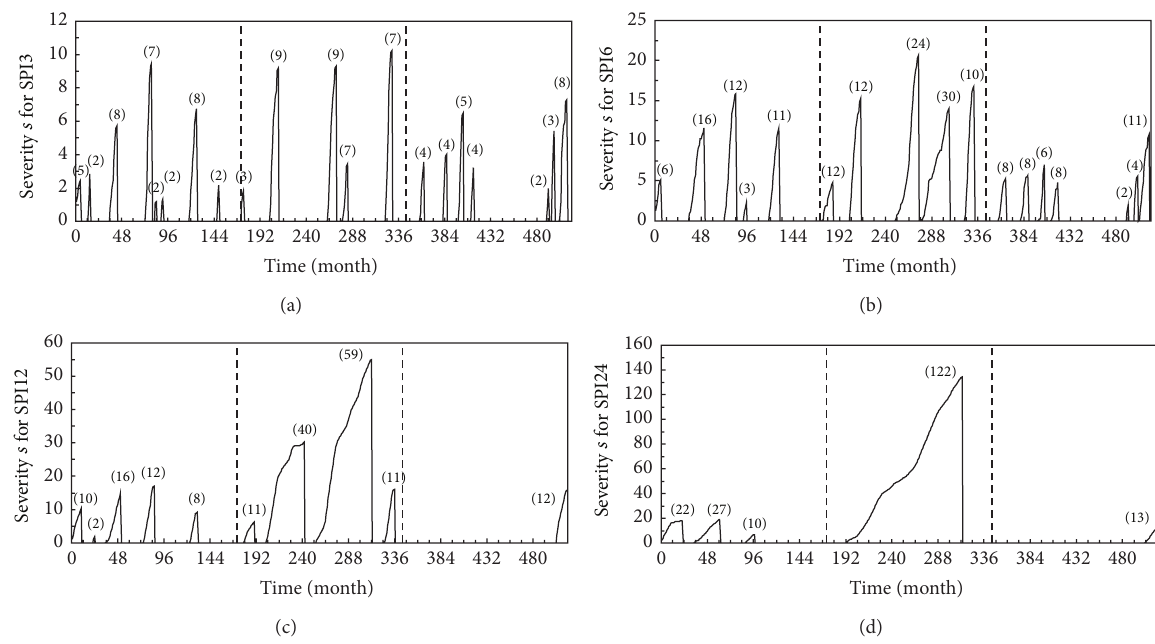
Figure 5: Drought severity for SPI3, SPI6, SPI12, and SPI24. The spikes represent the successful drought events. The numbers in the parentheses represent the drought durations. The time duration of the data is from January 1967 (month number 1) to December 2009 (month number 516). The two dashed lines are used to divide the data into three distinct equal time intervals corresponding to those found in Figure